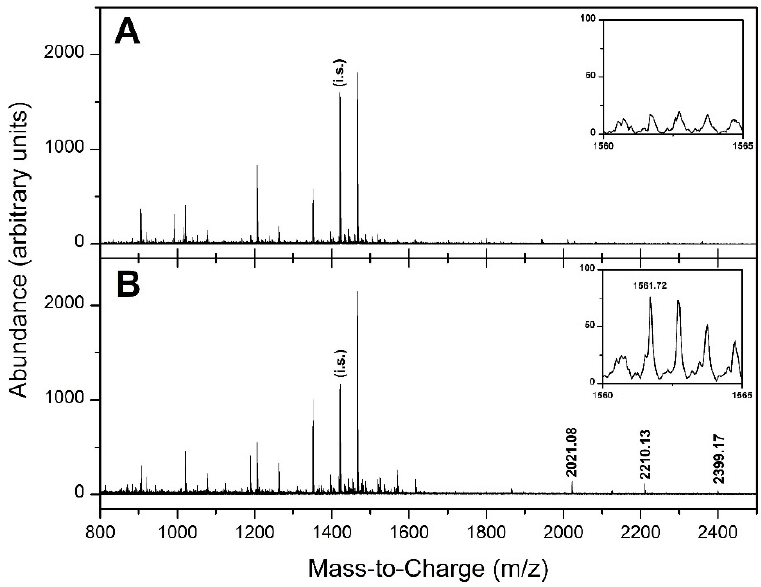
Figure 1. Serum sample spectra. The figure includes two spectra: healthy control ( A ) and metastatic colorectal cancer (CRC) patient ( B ). The intervals around the fragment at m / z 1561.725 have been zoomed (i.s.: internal standard).